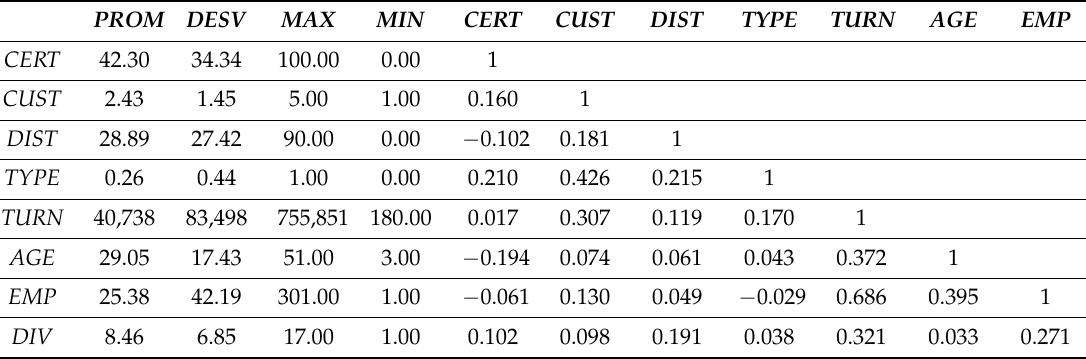
Table 2. Description of variables and